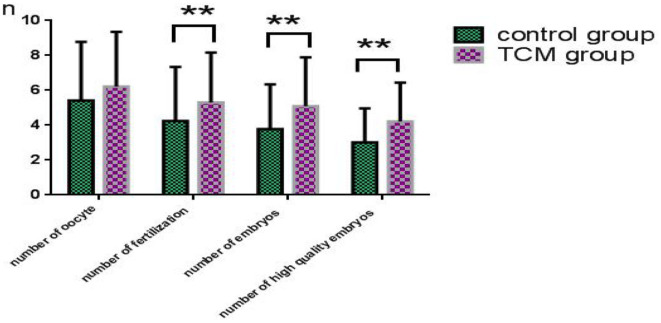
TCM treatment yielded more good quality embryos. **Means statistically significant much.